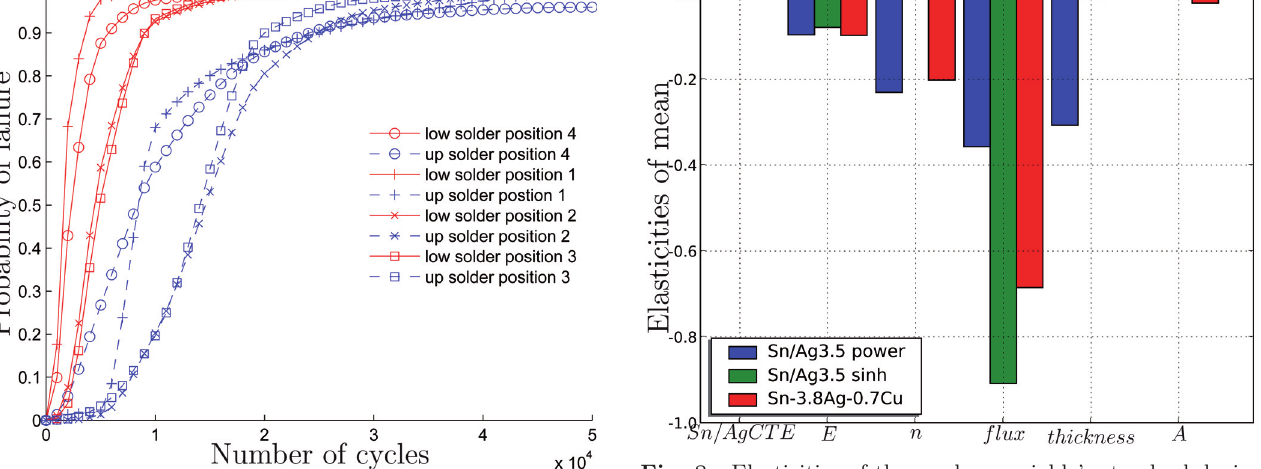
Fig. 6. Evolution of the probability of failure for the target number of cycles.